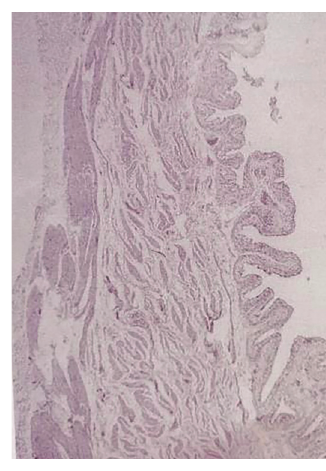
Group I: first control group, Group II: second control group, Group III: partial cystectomy only group, Group IV: early BAMA augmented cystoplasty group, Group V: late BAMA augmented cystoplast group, *: Kruskal VVallis test, ***: ml.